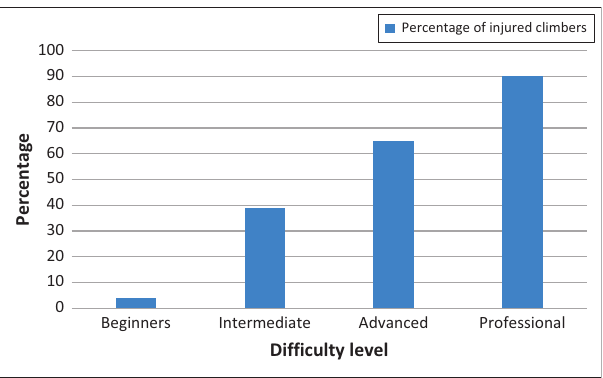
FIGURE 1: Percentage of injury according to difficulty of climbing. TABLE 1: Most common self-reported injuries by area and type. Area